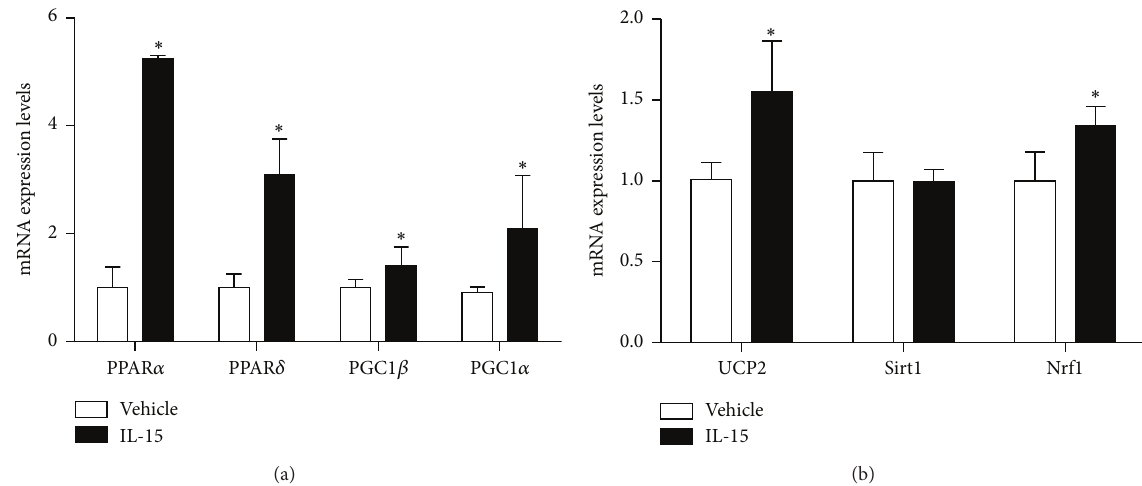
Figure 2: Effects of IL-15 signaling on mitochondrial associated factors. (a) mRNA expression of PPAR 𝛼 , PPAR 𝛿 , PGC1 𝛽 , and PGC1 𝛼 ; (b) mRNA expression of UCP2, SIRT1, and Nrf1. Assessments were carried out on differentiated C2C12 myotubes following treatment with 100ng/mL of IL-15 every other day for 6 days during the differentiation protocol. GAPDH was used as an internal control for qPCR analysis. All values are displayed as means ± SEM, 𝑛 = 6–9 per group, ∗ 𝑃 < 0.05 .